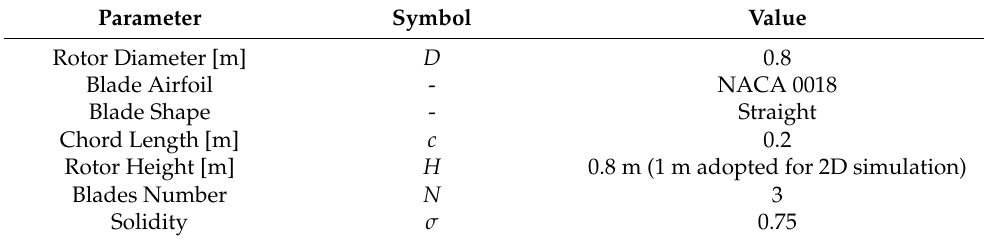
Table 2. Design Parameters of the H-Darrieus Wind Turbine [22].